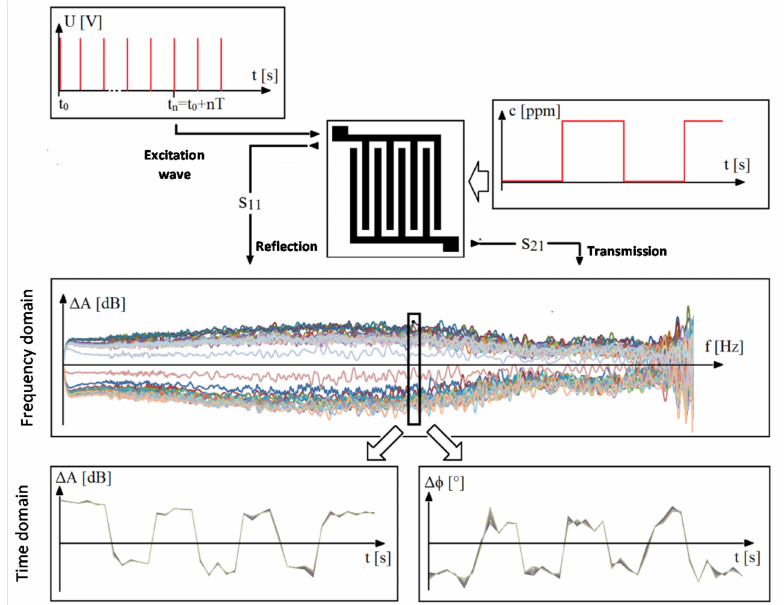
Figure 4. Context visualization of the